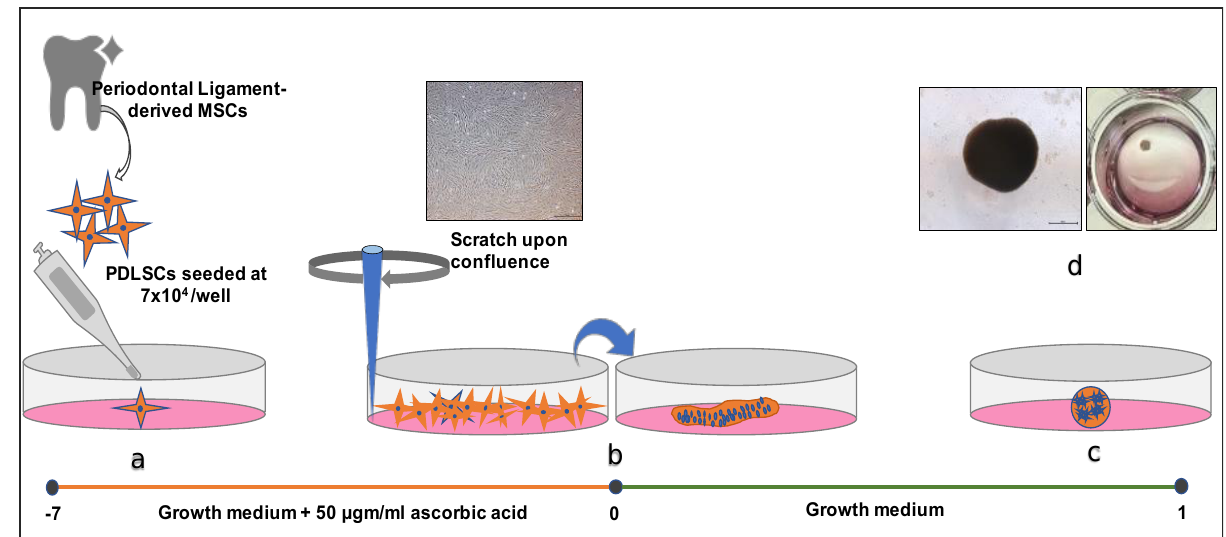
Figure 3. Preparation of C-MSCs. ( a ) PDSLCs were cultured in a 24-well plate with the addition of 50 µgm/mL L-ascorbic acid for seven days. ( b ) The confluent cells were scratched to gently tear off as a cellular sheet that consists of ECM. ( c ) After one-day incubation with growth media alone, cells rolled up to make spherical clumps. ( d ) C-MSC in a 24-well plate observed under a bright-field microscope. Scale bar 50 µm.